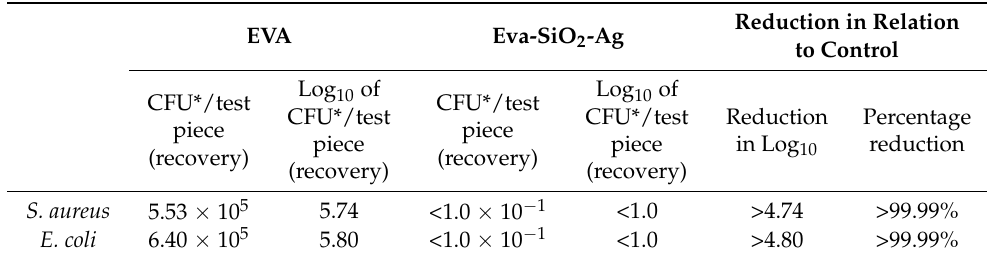
Table 1. Results of the efficacy evaluation of biocides incorporated into specimens against S. aureus (ATCC 6538) and E. coli (ATCC